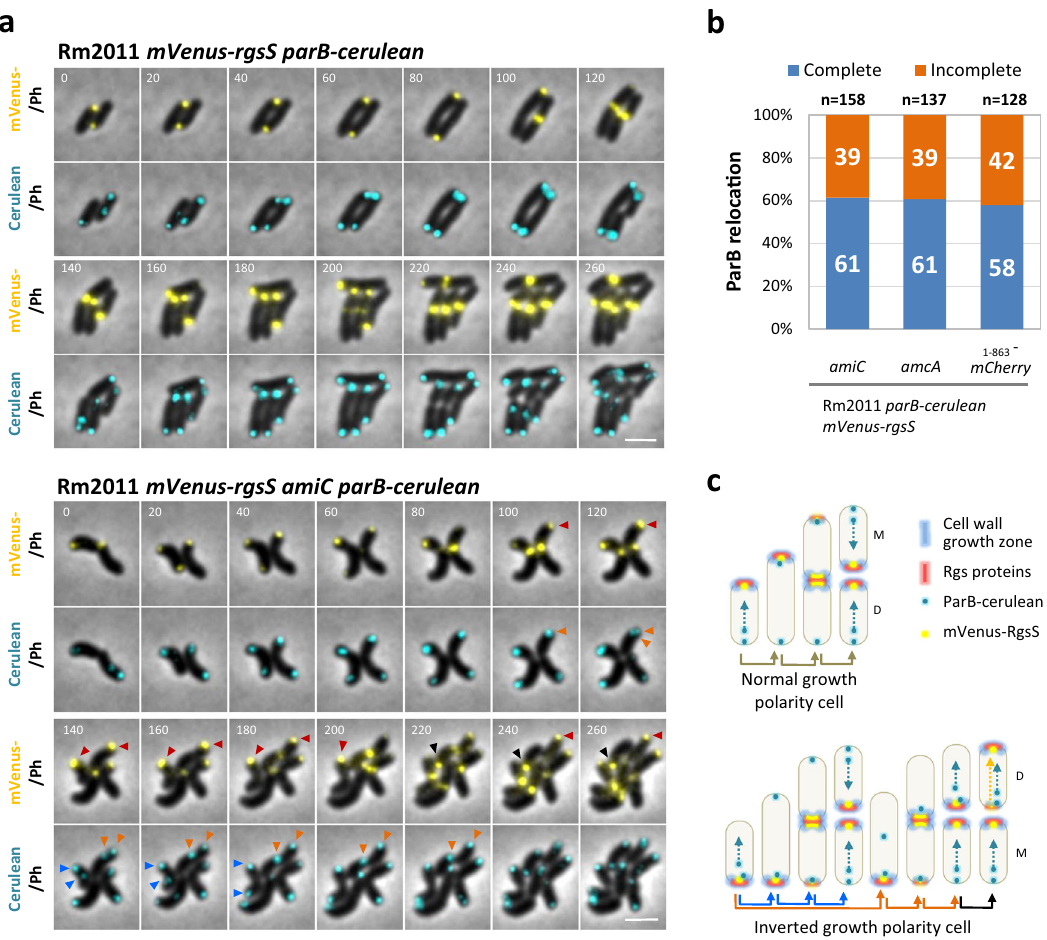
Fig. 4 Effects of inverted cell growth polarity on segregation of chromosomal origins. a Time-lapse fl uorescence microscopy images of Rm2011 mVenus- rgsS wild type and its amiC mutant derivative, carrying parB-cerulean at the native genome location, growing on MM-agarose. Red and black arrowheads indicate accumulation of mVenus-RgsS at the old cell pole of the daughter cell (red) or a mother cell (black). Blue and orange arrowheads show complete (blue) or incomplete (orange) ParB-cerulean focus relocation to the opposite cell pole of a cell with inverted growth polarity. Time is shown in minutes. Scale bar, 2 µ m; Ph phase contrast. The images are representative of three independent cultivations and microscopy analyses. b ParB-cerulean focus migration towards the new cell pole in cells with mVenus-RgsS focus at the old cell pole. n, total number of analyzed cells. The values represent the mean values of three biological replicates. The standard deviation values and statistic comparison between the strains are shown in Supplementary Table 7. c Schematic representation of ParB-cerulean spatiotemporal patterns observed in a . In case of cells with normal growth polarity, newborn cells contained a ParB-cerulean focus marking oriC 1 at the old cell pole and the migration of a second ParB-cerulean focus marking oriC 2 proceeded towards the growing cell pole. In cells with inverted growth polarity, which accumulated the Rgs proteins, which are considered markers for the PG growth zones, at the old cell pole, the migration of the second ParB-cerulean focus marking oriC 2 proceeded towards the non-growing cell pole. This resulted in either complete (blue arrows) or incomplete (orange arrows) polar relocation of the second ParB-cerulean focus. A part of the cells that inherited a ParB-cerulean focus at the new cell pole accumulated mVenus-RgsS at the former non-growing pole (black arrow). The color coding is consistent with a . D daughter cell, M mother cell. The large proportion of free tracks concentrated in the (Fig. 5c). In mVenus-rgsS 1 − 863 cells, the polar enrichment of the narrow polar zone may indicate high on/off rates for binding protein molecules, the size of the static fraction and the residence of mVenus-RgsS to its polar target sites, possibly due to a time were strongly reduced (Fig. 5a – c). This is consistent with our highly dynamic molecular environment in the polar cell previous observations of weaker or even non-detectable polar mVenus-RgsS 1 − 863 foci (Fig. 1a and Supplementary Figs. 5 and 11). Since removal of the SPOR domain destabilized RgsS (Fig. 1d), it is likely that part of the mVenus-RgsS 1 − 863 molecules detected during tracking represented degraded protein. To further characterize the spatial dynamics of mVenus- RgsS, mVenus-RgsS 1 − 863 and mVenus-RgsS 1 − 863 -mCherry molecules, the tracks were classi fi ed regarding their ability to leave the de fi ned con fi nement area (Supplementary Fig. 24 and Supplementary Table 9). In the mVenus-rgsS wild type- strain, both con fi ned (29%) and free (68%) tracks were almost exclusively detected at the pole (Supplementary Fig. 24). NATURE COMMUNICATIONS| (2021) 12:545